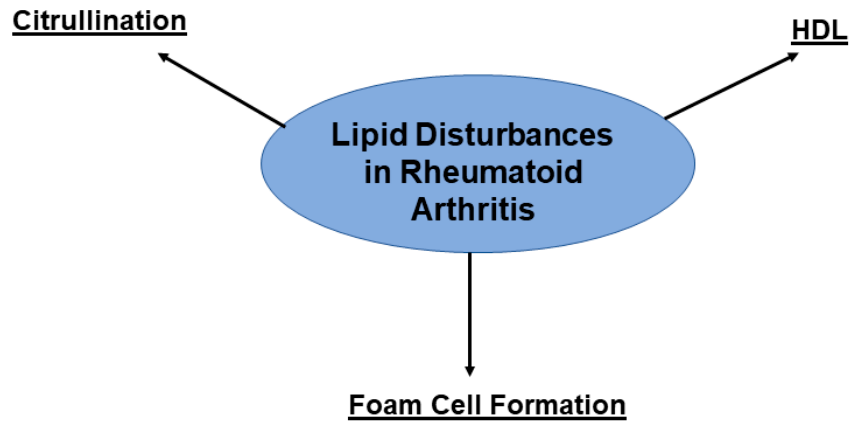
Figure 1. Pro-atherogenic disordered lipid transport and processing in RA. Both low density lipoprotein (LDL) and high density lipoprotein (HDL) are impacted by the inflammatory milieu in RA. Disruptions in lipid composition and transport observed in RA include (1) Citrullination. Citrullinated and homocitrullinated forms of LDL have atherogenic properties and may be abundant in RA plasma. (2) HDL abnormalities. Circulating levels of HDL may be low and paraoxonase 1 (PON1) activity of HDL impaired. Poorly functioning PON1 reduces antioxidant capacity of HDL. (3) Enhanced foam cell formation. Downregulation of cholesterol efflux proteins coupled with upregulation of scavenger receptors attenuates cholesterol outflow and increases oxidized LDL uptake within macrophages leading to lipid overload and formation of foam cells. TNF- α increases levels of oxidatively modified LDL via augmentation of reactive oxygen species generation.